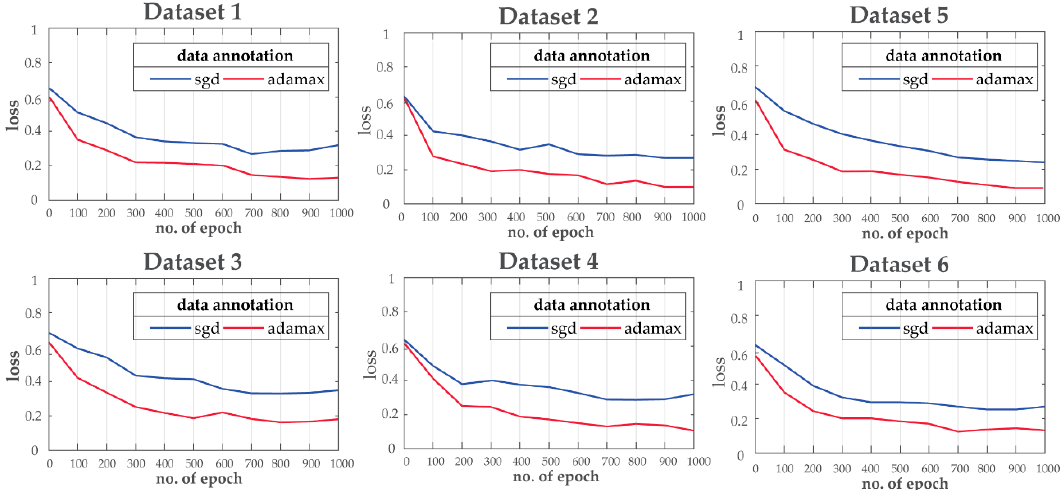
Figure 6. Training loss curve comparisons for different datasets.